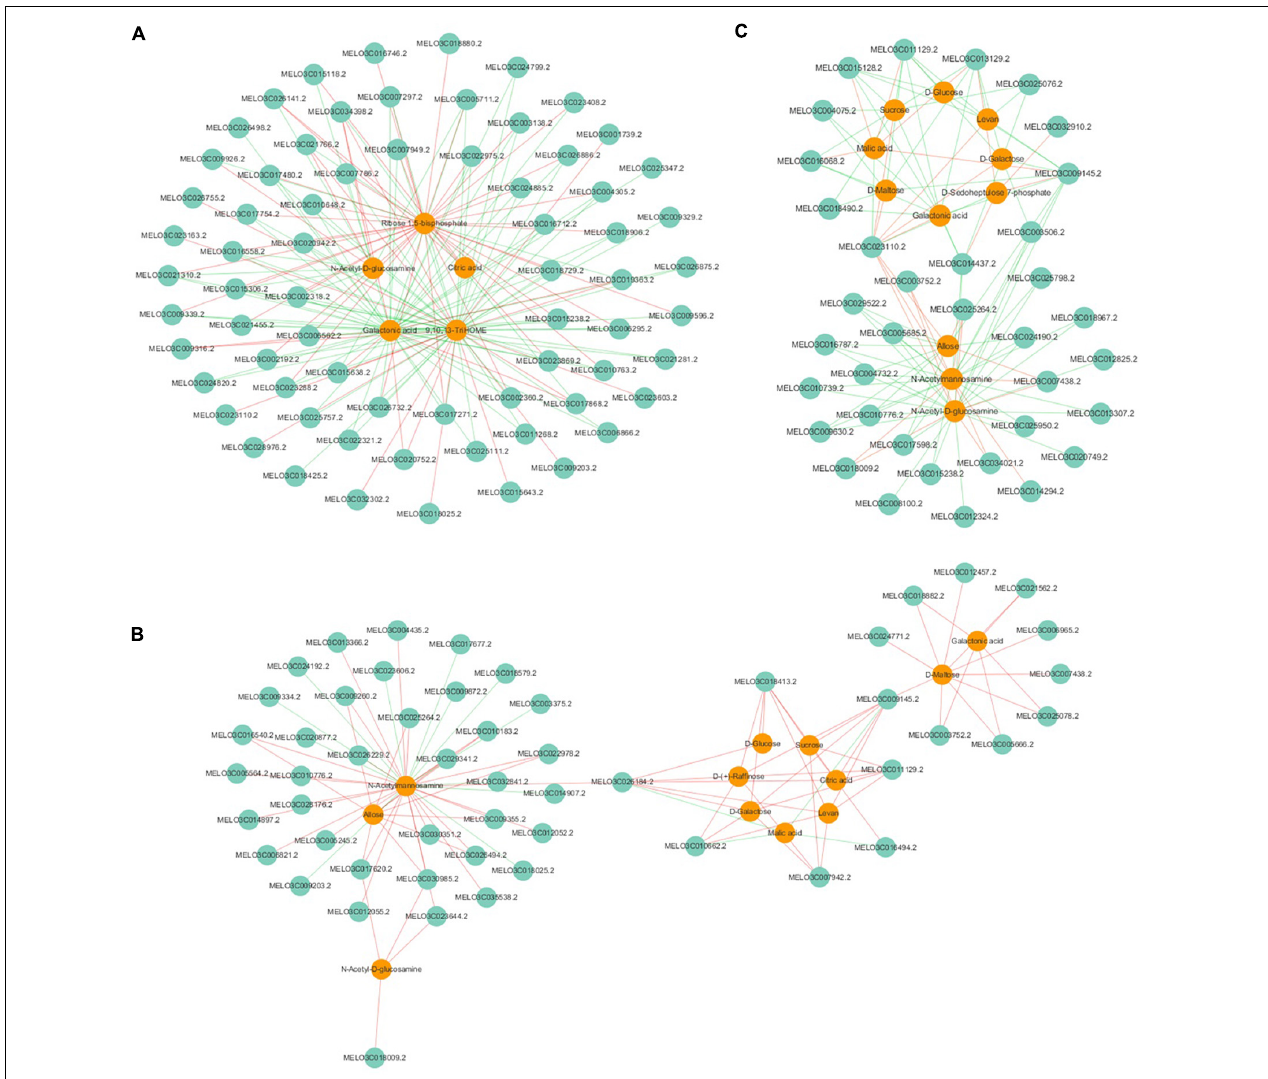
FIGURE 5 | Correlation network of DEGs and DAMs involved in sugar and organic acid metabolism. (A) AFS1 vs. BFS1, (B) AFS2 vs. BFS2, (C) AFS3 vs. BFS3. Green circles indicate genes, and orange circles indicate metabolites. Lines colored in “red” and “green” represent positive and negative correlations, respectively, as determined by a Pearson’s correlation coefficient > 0.8 or < − 0.8 ( q -value < 0.1),